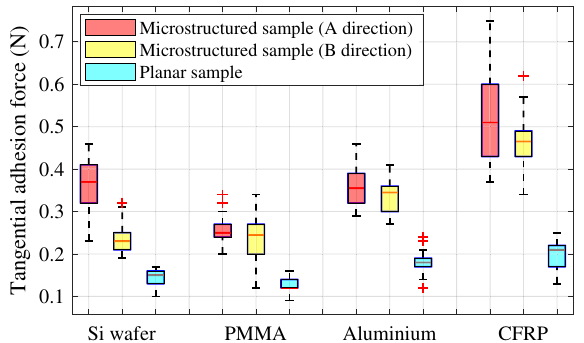
Figure 6. Tangential adhesion force of samples self-attached to different holding materials, for two pulling directions using microstructured packaging and using a planar packaging. Boxplots show the statistical distribution of the measured force resulting from 30 tests performed for each of the analysed conditions.